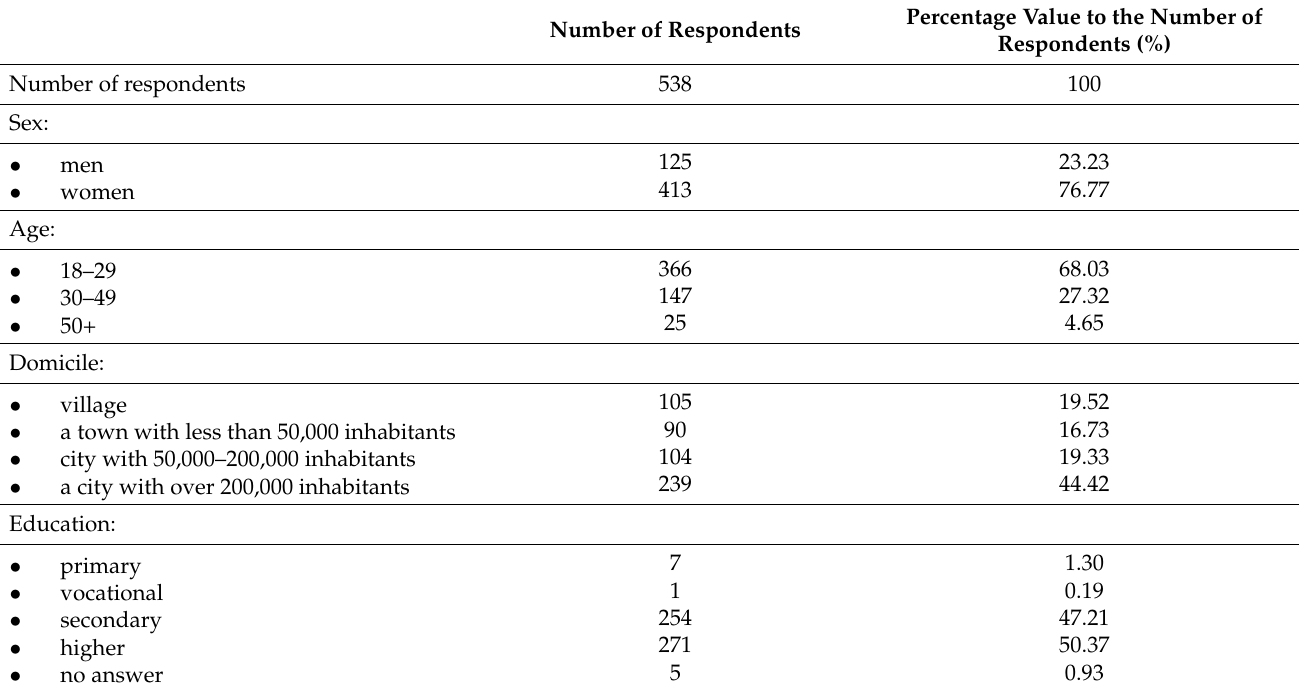
Table 1. The demographic structure of the studied